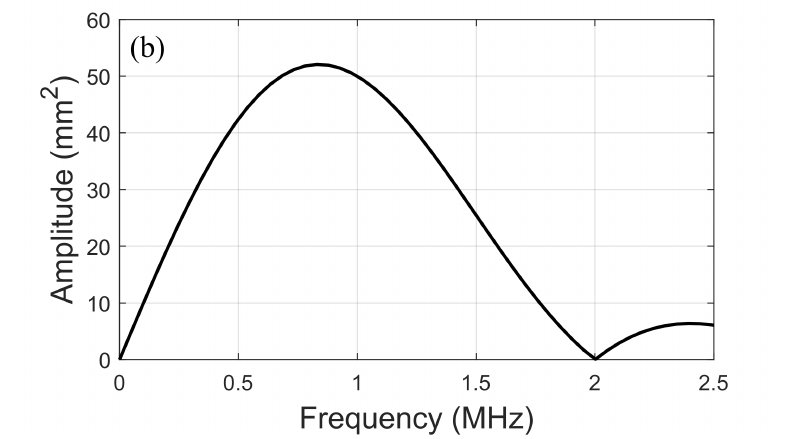
Figure 2. ( a ) Designed loading function in the time domain and; ( b ) designed loading function in the frequency domain. Table 1. Material’s properties.